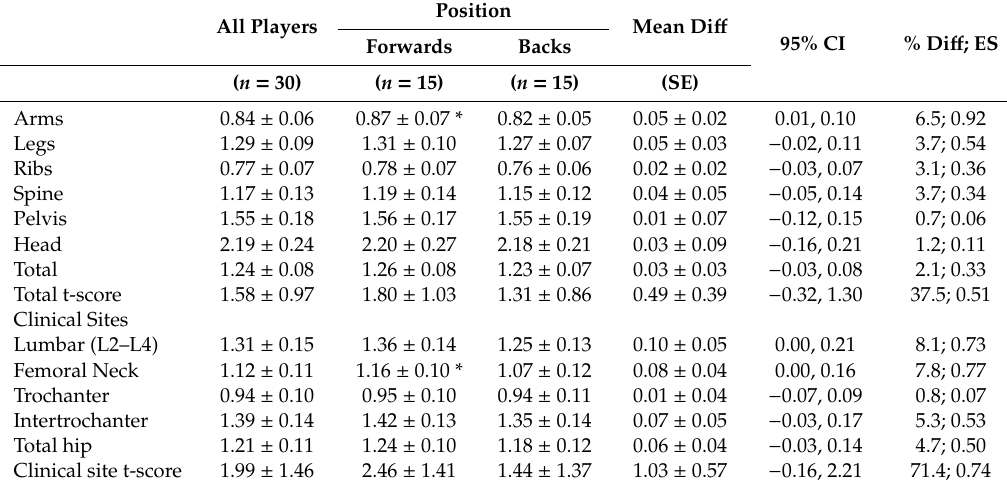
Table 3. Total and clinical site BMD (g / cm 2 ) of elite female RU